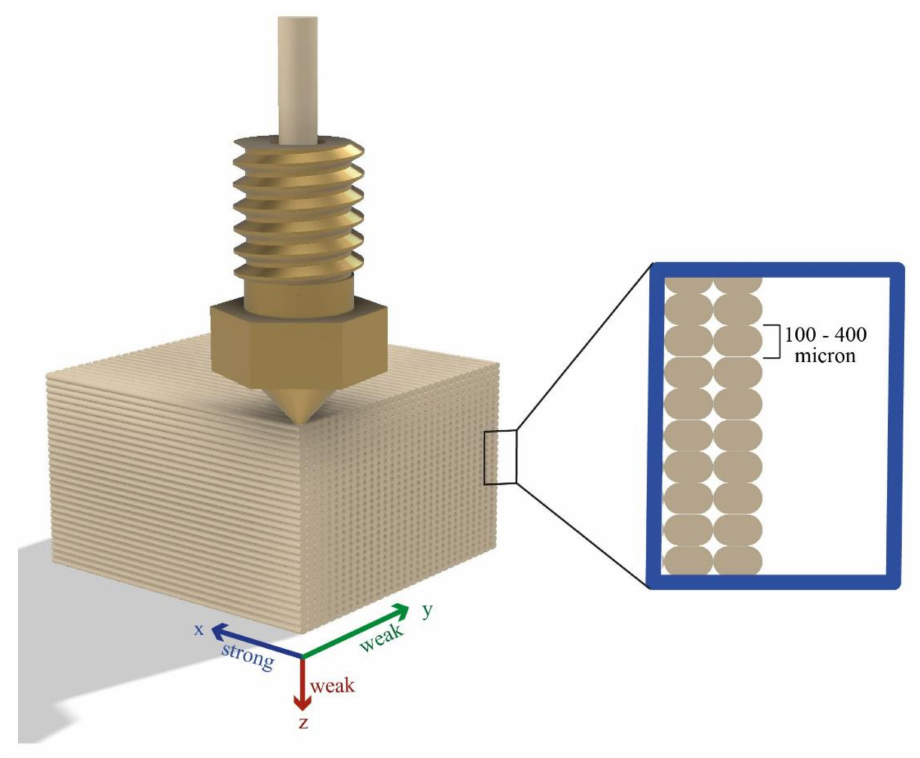
Figure 4. Reasons for the problems of the 3D-printed PLA objects due to the printing direction of the fused